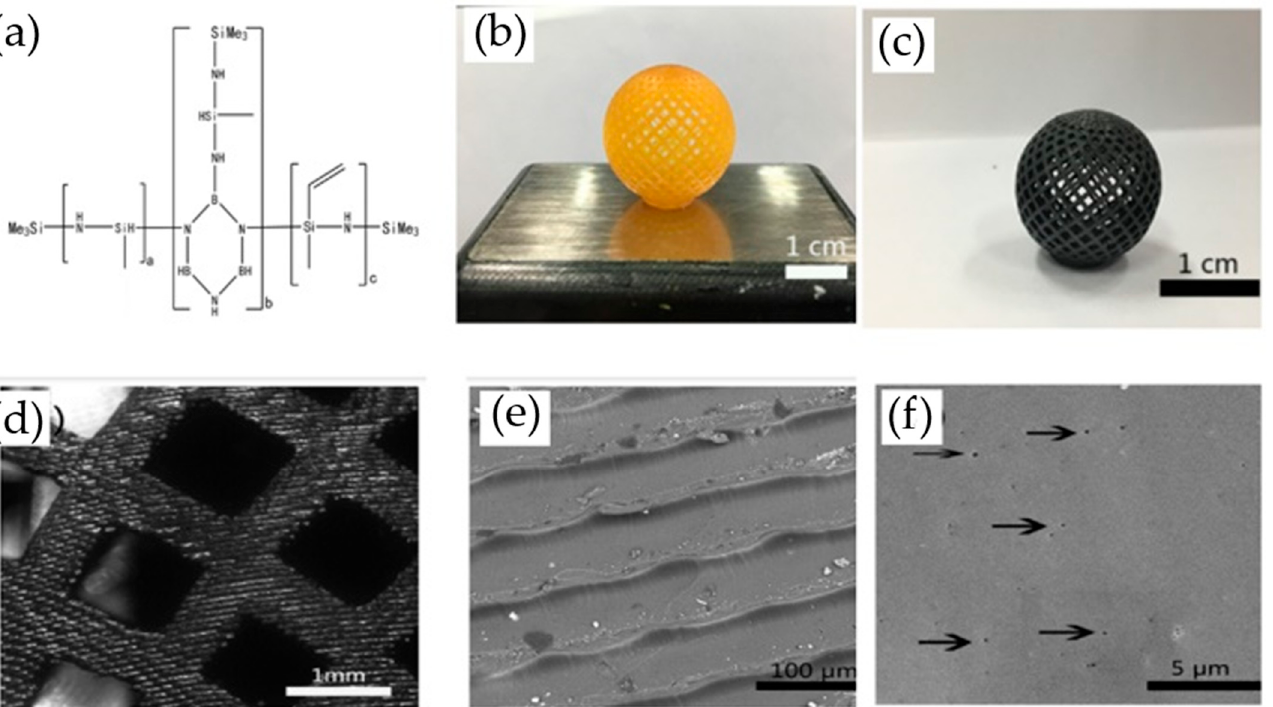
Figure 32. 3D printing of polymer-derived ceramics (adapted with permission from reference [150,151]).